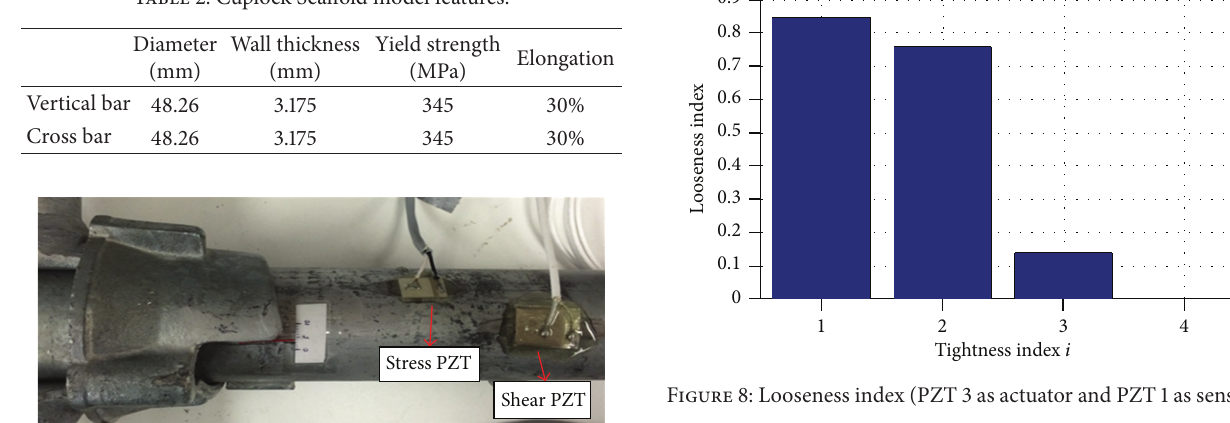
into 32 signal sets. 32 signal sets are enough for the